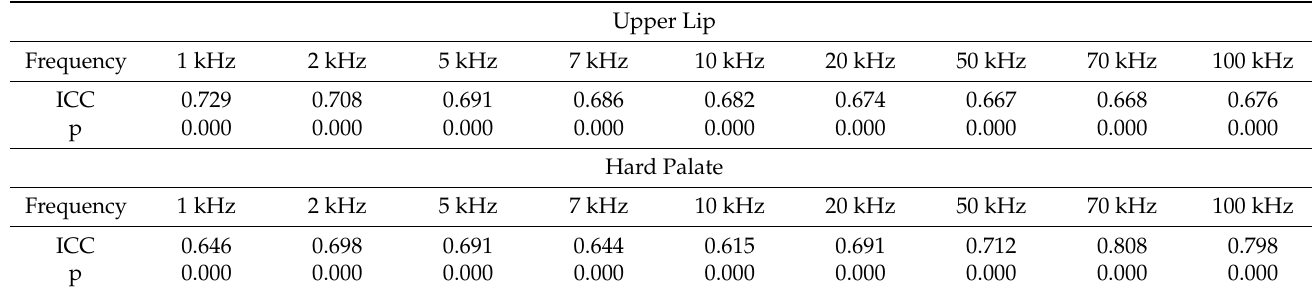
Table 3. Intra-rater statistics for measurements at the sub pressure of 350